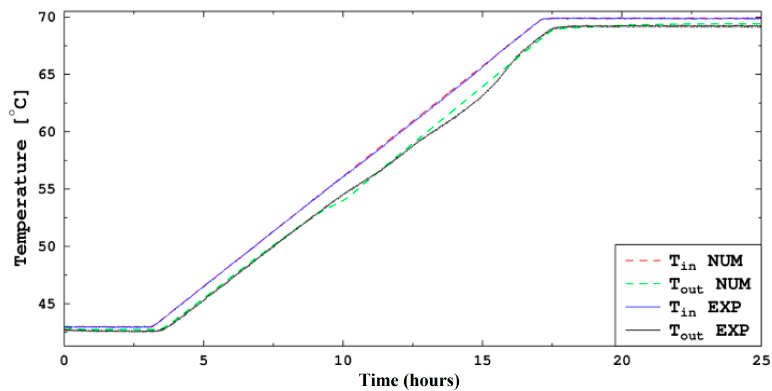
Figure 7. Charge mode from 43 to 69.9 °C at 2 °C/h and 180 L/h .